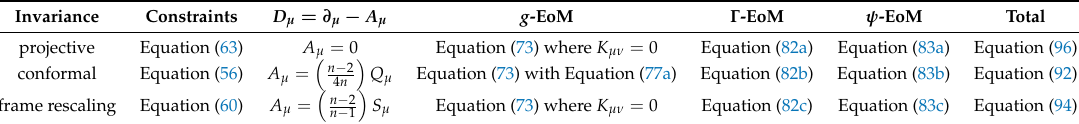
Table 2. The invariant actions (given by Equation (53) by taking into account the constraints and the prescription for the derivative) and the equations of motion. The final column refers to the parameter constraints on the total action Equation (87) to be derived in Section